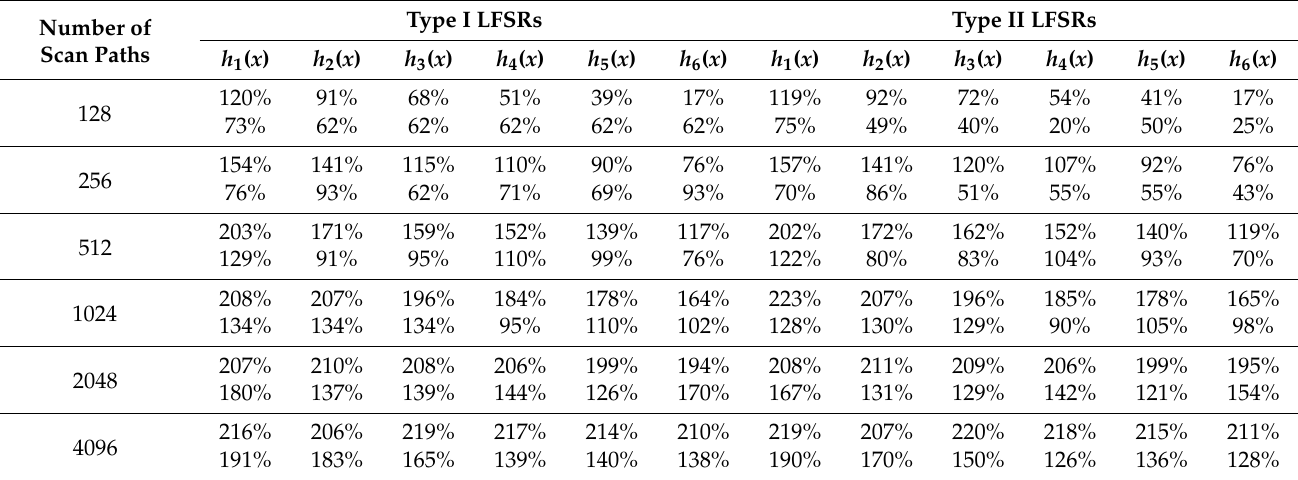
Table 10. Comparison of implementation costs and maximum operating frequencies between test pattern generators of the LFSR + PS and DT-LFSR-TPG